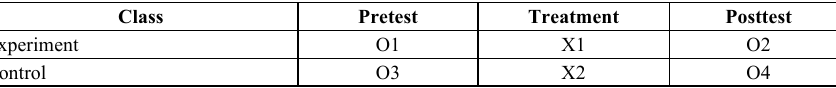
Table 1. Design analysis